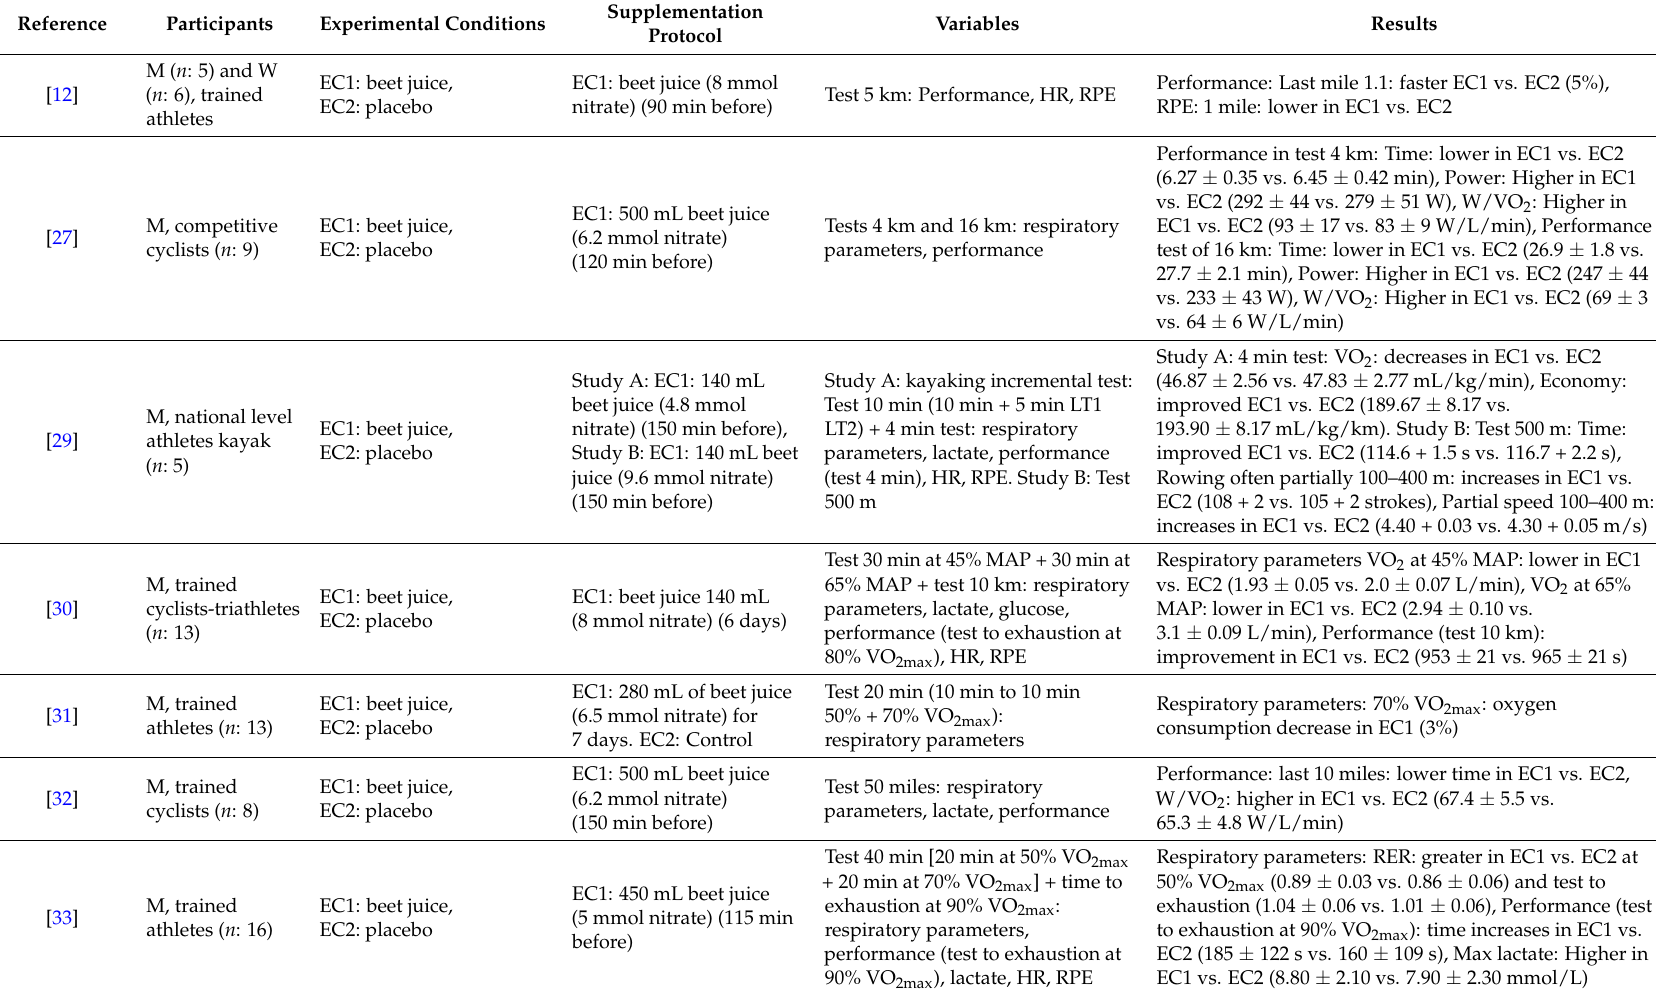
Table 2. Summary of studies that have evaluated the performance or metabolic responses after supplementation protocol with beet